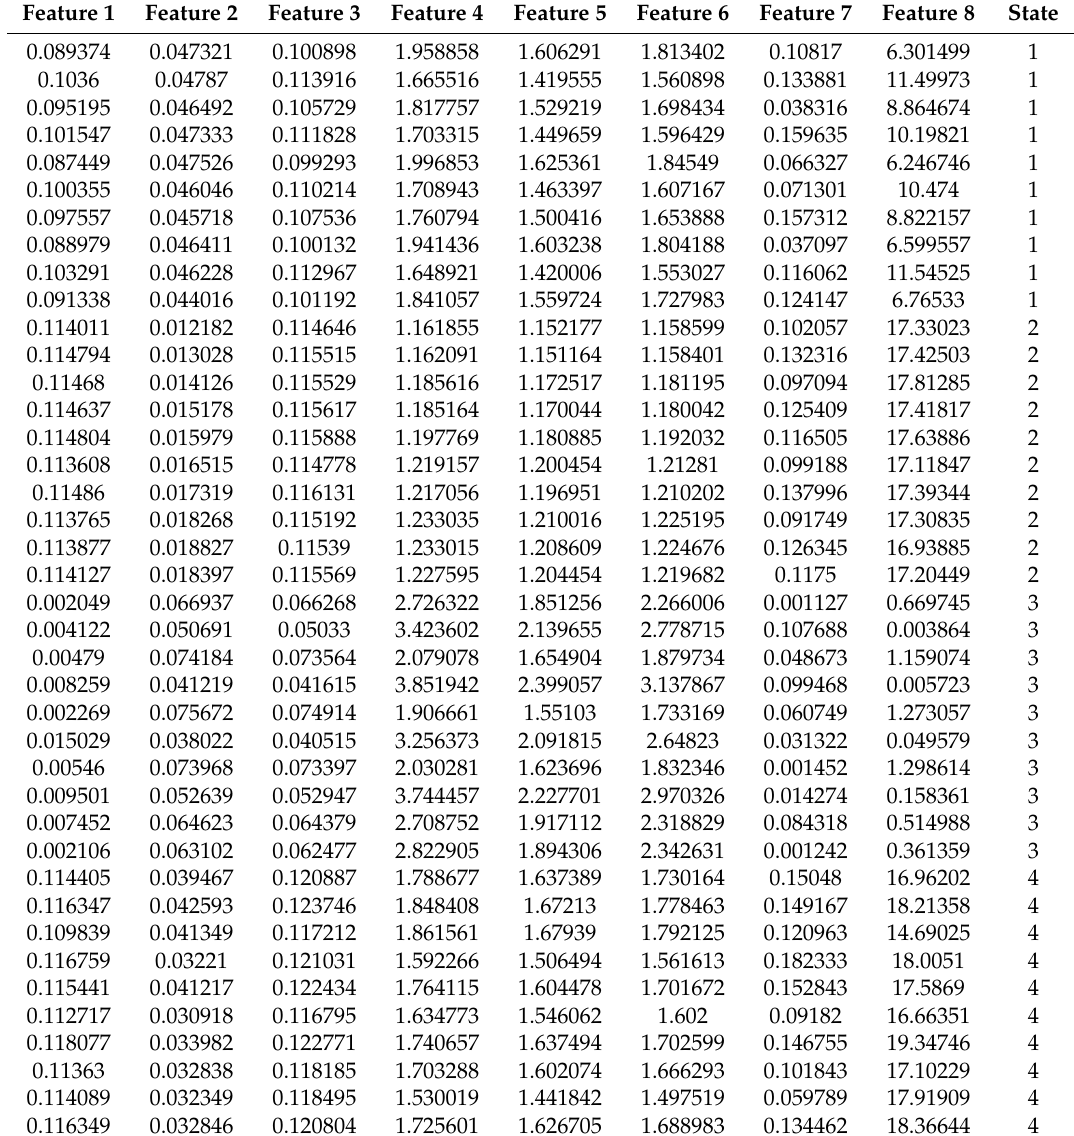
Table 1. Fault data